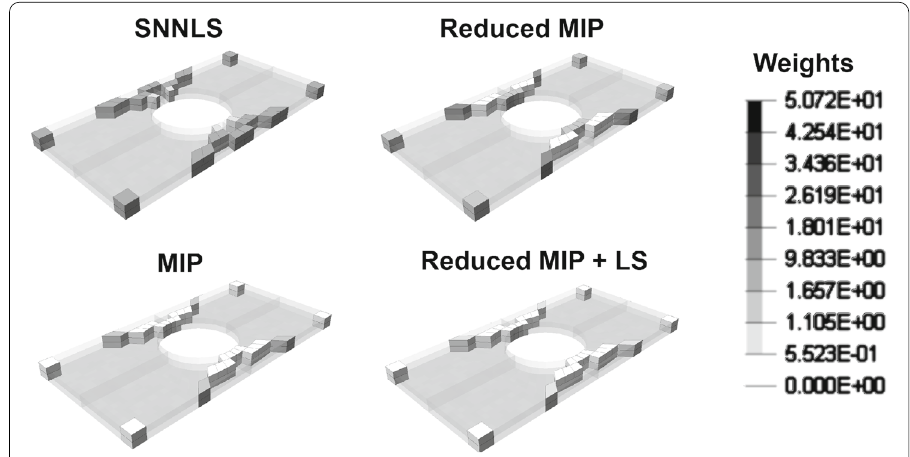
Fig. 13 Element selection for the hyper-reduced integration schemes of size seven computed with the different methods